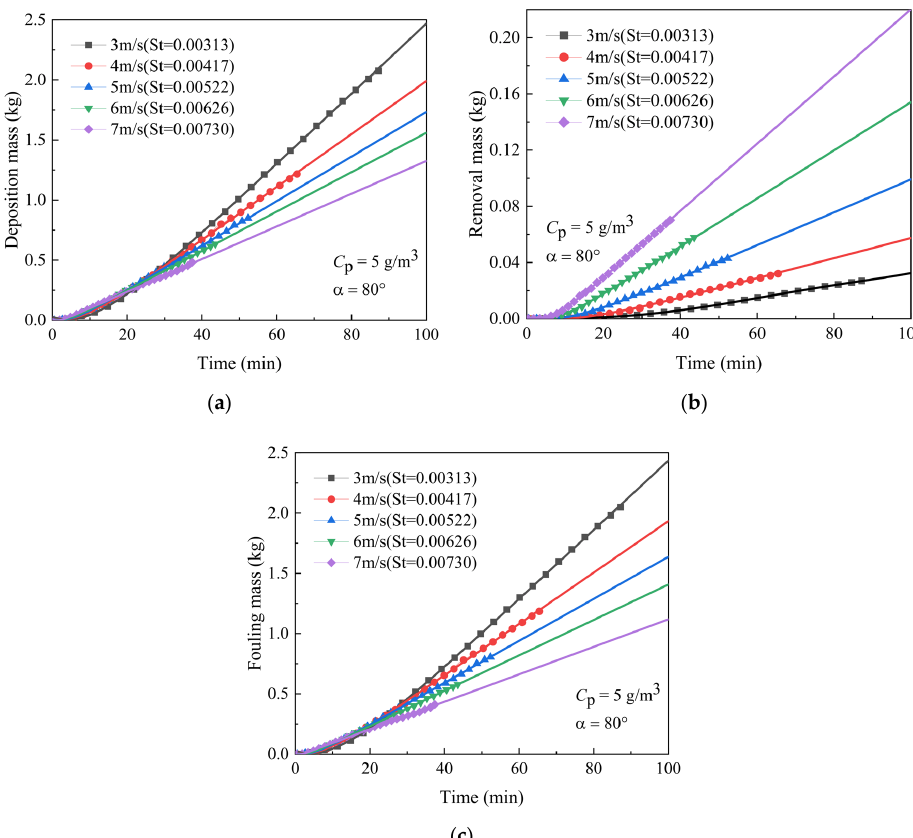
Figure 12. Particle deposition mass, removal mass, and fouling mass versus time at the different velocities. ( a ) Deposition mass; ( b ) Removal mass; ( c ) Fouling mass.